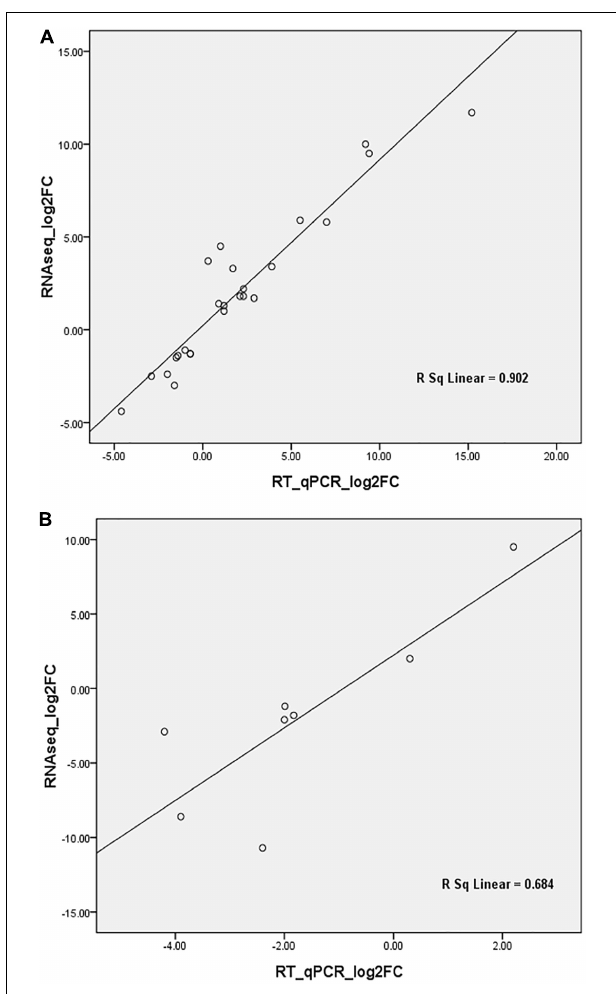
FIGURE 6 | Correlation analyses of differential gene expression by RT-qPCR and RNA-seq. (A) verification analyses for differentially expressed genes; (B) verification analyses for differentially expressed miRNAs. FC, Fold